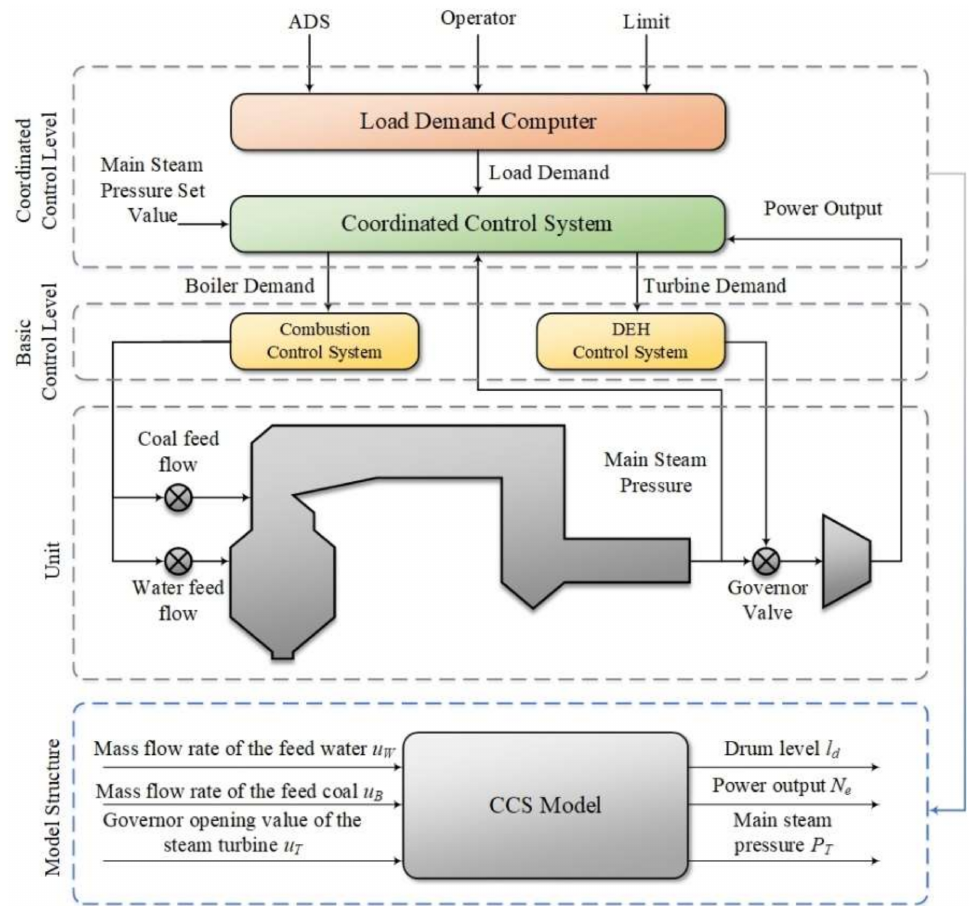
Figure 3. The working principle and the model structure of